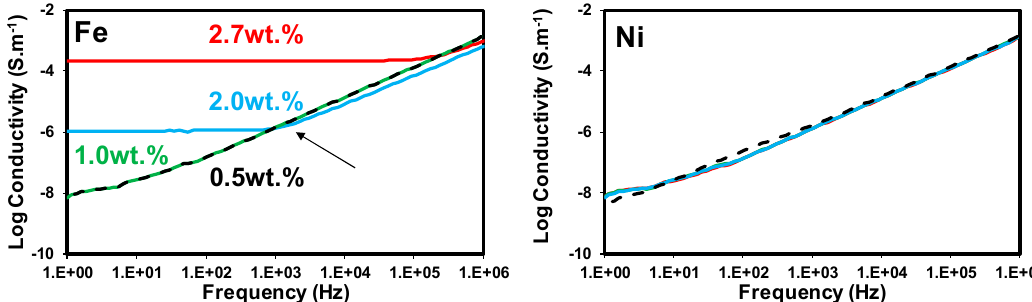
Figure 2. Broadband electrical conductivity of N-CNT/PVDF nanocomposites with different N-CNT loadings. N-CNTs were synthesized over Fe and Ni catalysts. Reprinted with permission from Ref. [15], with permission from Elsevier, 2020.